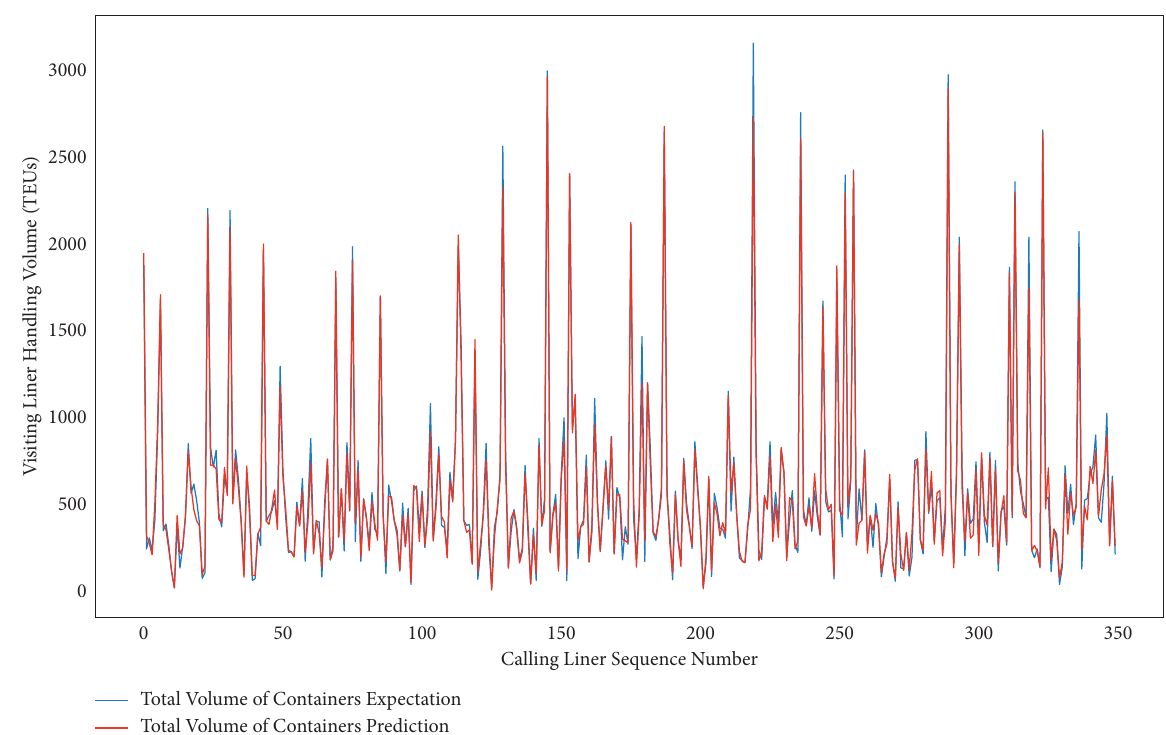
Figure 8: A comparison of predicted values and true values of LHV by LHV-SIX.